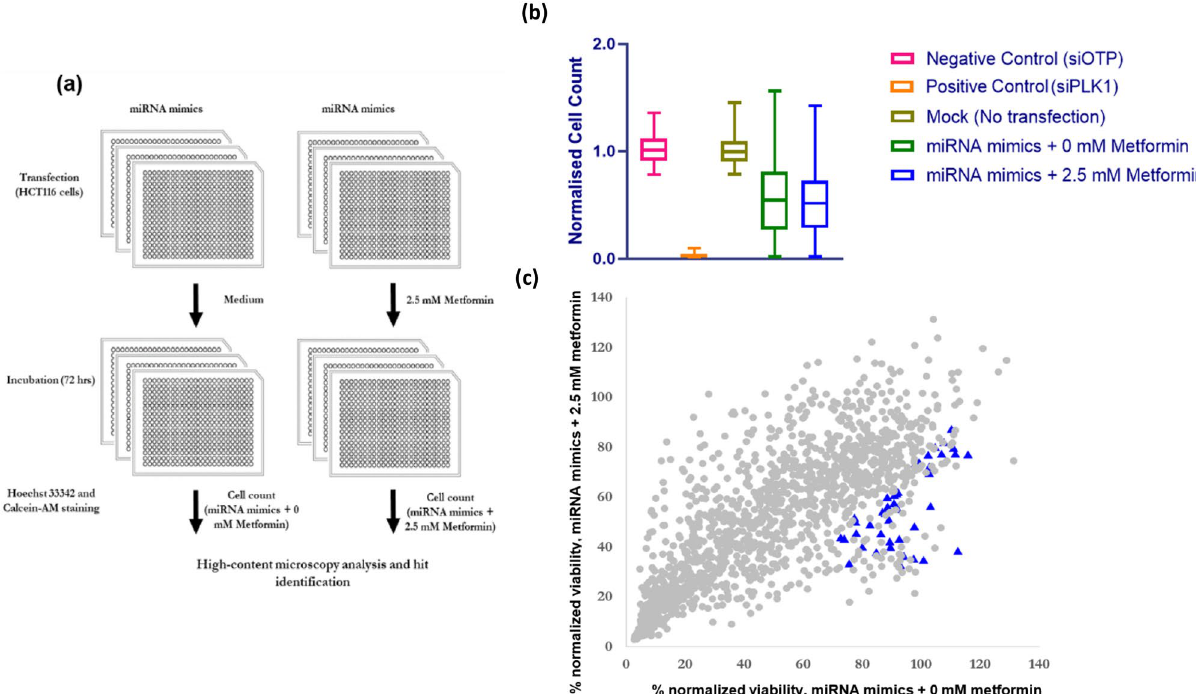
Figure 1. Schematic of high throughput screen of miRNA mimics, summary of data for CRC cell response to metformin treatment and scatter plot representation of the metformin sensitization screen with a miRNA mimic library. ( a ) Workflow of functional miRNA mimic screen is demonstrated. HCT116 cells were reverse transfected with 25 nM miRNA mimics and following 24 h incubation, cells were treated with 2.5 mM metformin or control medium for 72 h. Endpoint high-content image analysis was performed for cells stained with Hoechst 33342 and Calcein-AM. ( b ) Summary of viability data for the functional high throughput screen of miRNA mimics in combination with metformin is shown. Negative control for cell death is represented by the viability of cells transfected with negative control (OTP) and positive control is represented by the cells transfected with siRNA targeting PLK1. Mock control also shows the control for transfection ( c ) Percent viability of HCT116 cells reverse transfected with miRNA mimics and treated with 2.5 mM (y- axis) or 0 mM metformin (x-axis) are shown. The viability values were normalized against siOTP values and miRNAs selected for a secondary screen (blue triangles). miRNA Viability: miRNA Viability: miRNA + metformin